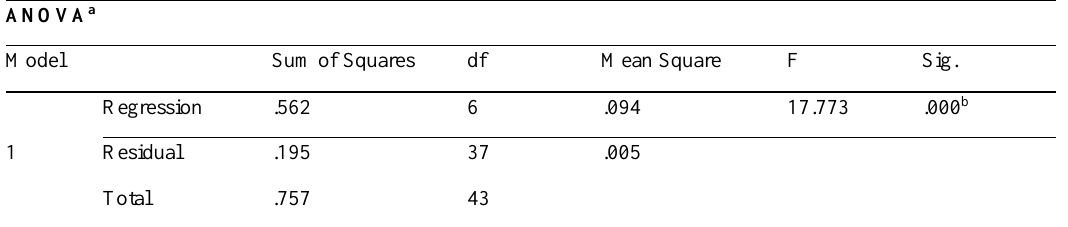
Table 10: ANOVA for Extent of Utilization of Performance Contracting as a Tool for Strategy Implementation ANOVA